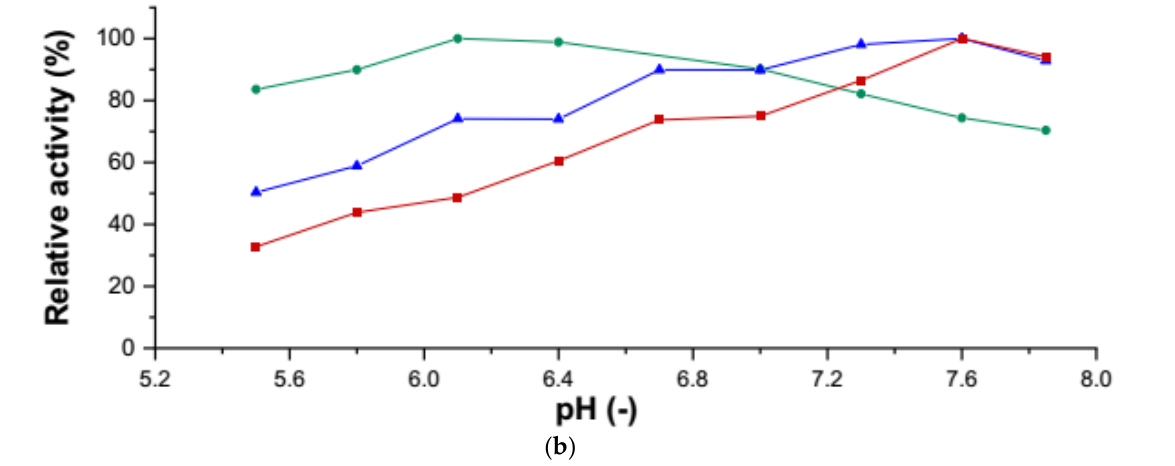
Figure 6. ( a ) Determination of the pH-optimum of r Cab UPO 1 ( ▲ ), r Cab UPO 2 ( ∎ ), and r Ani UPO (●) using ABTS as a substrate. An activity of 100% corresponds to the highest activity measured for each individual enzyme. ( b ) Determination of the pH-optimum of r Cab UPO 1 ( ▲ ), r Cab UPO 2 ( ∎ ), and r Ani UPO (●) using NBD as a substrate. An activity of 100% corresponds to the highest activity measured for each individual enzyme.